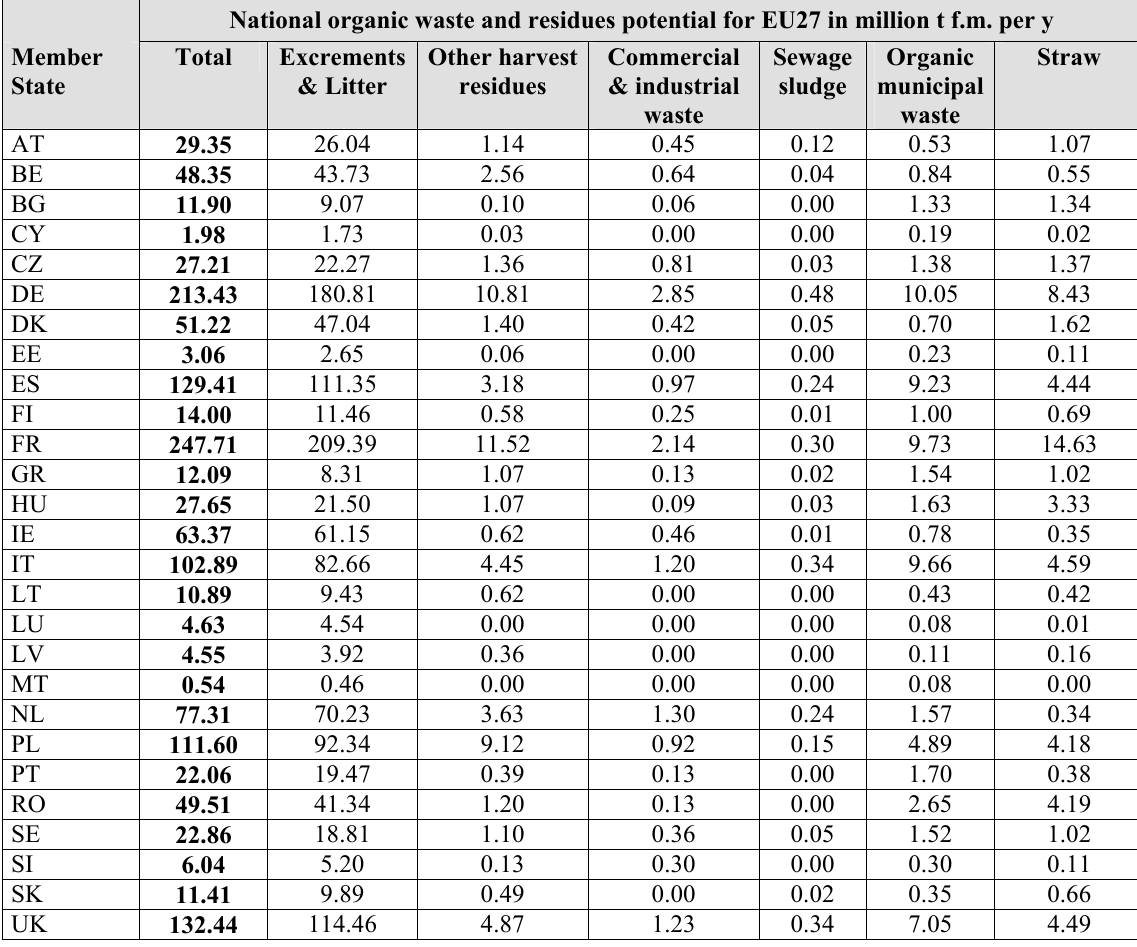
Table 43: Country specific potential of organic residues and waste in EU for 2020 (Thrän, 2007) National organic waste and residues potential for EU27 in million t f.m. per